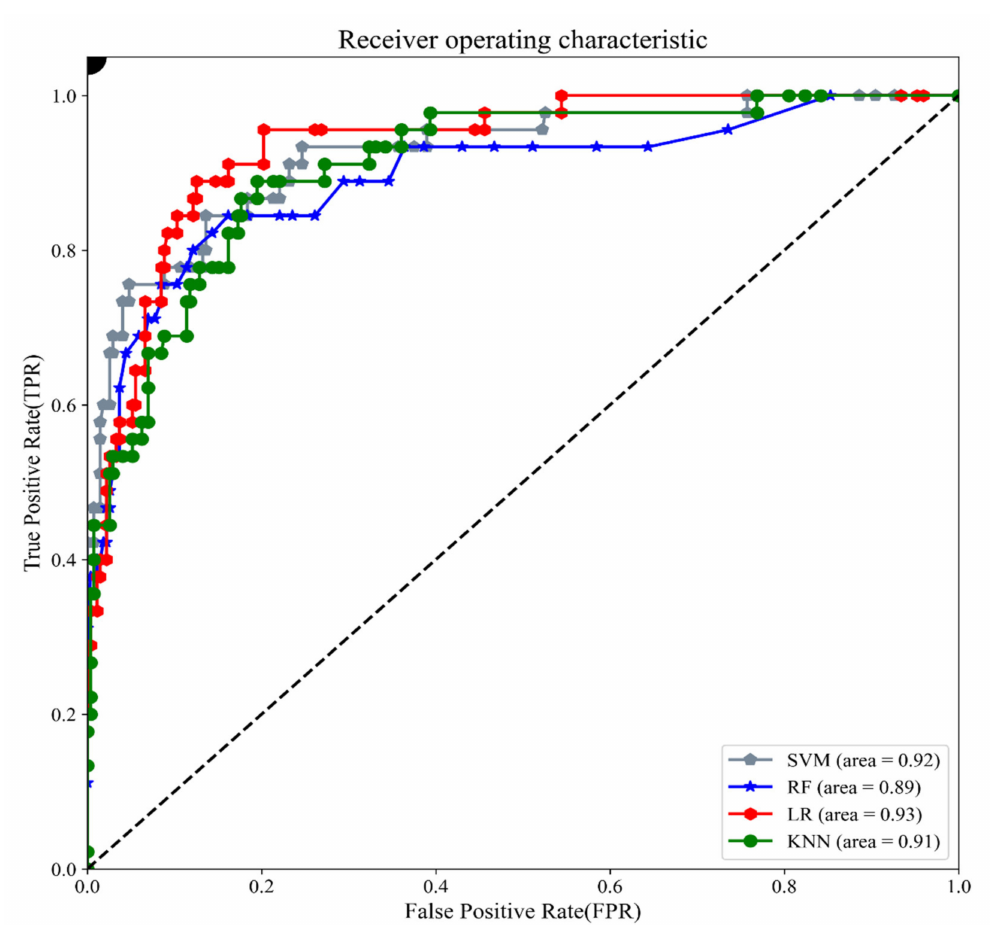
Figure 6. ROC curves of KNN, LR, RF, and SVM on sample data after being filtered by multi-source semantic